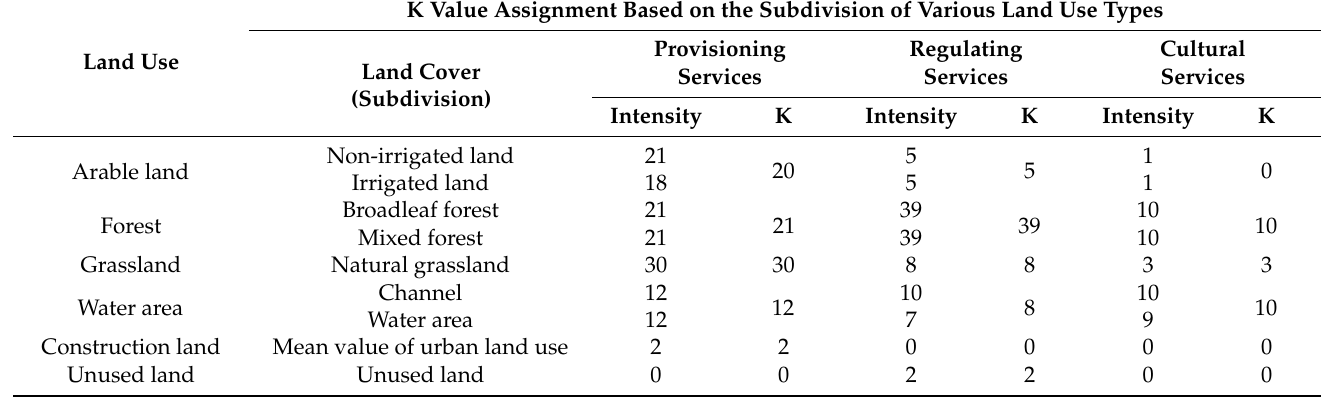
Table 2. The intensity and K value of ecosystem services supply of various land use